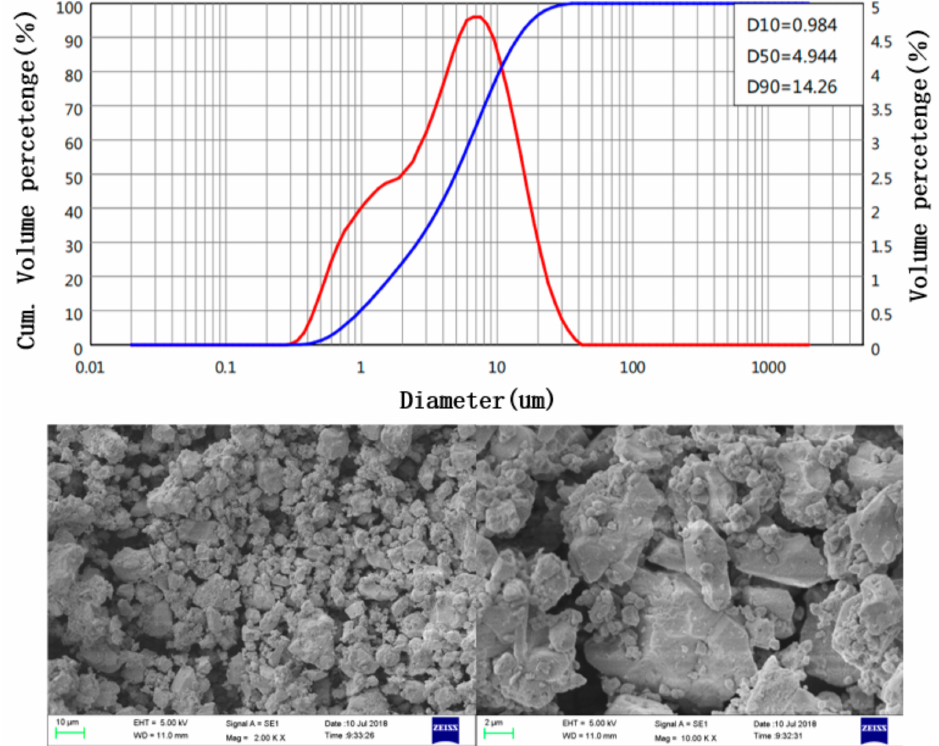
Figure 17. SEM photography and particle size distribution of silica